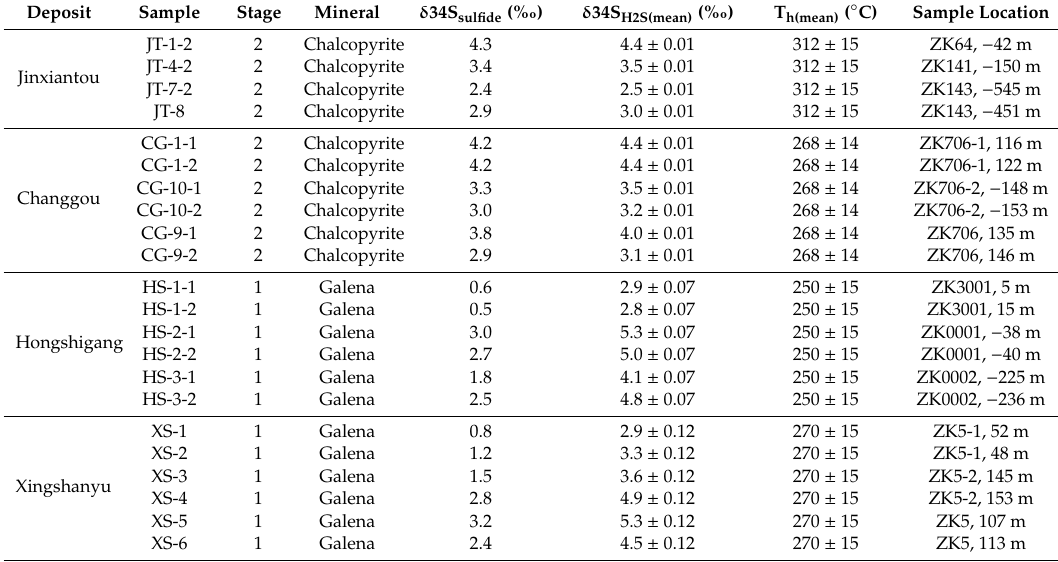
Table 3. Sulfur isotopic data for ore minerals from the Qibaoshan polymetallic ore field. Deposit